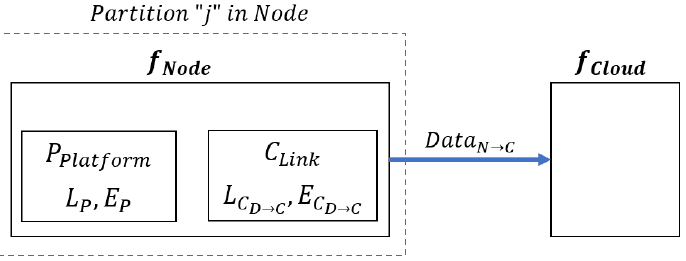
Figure 2. Computational and communication load of a